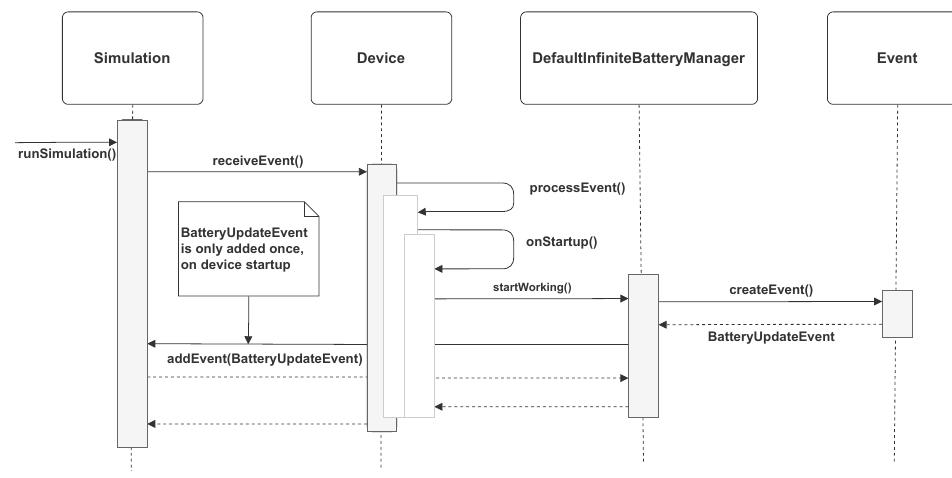
Figure A1. Sequence Diagram of DewSim battery